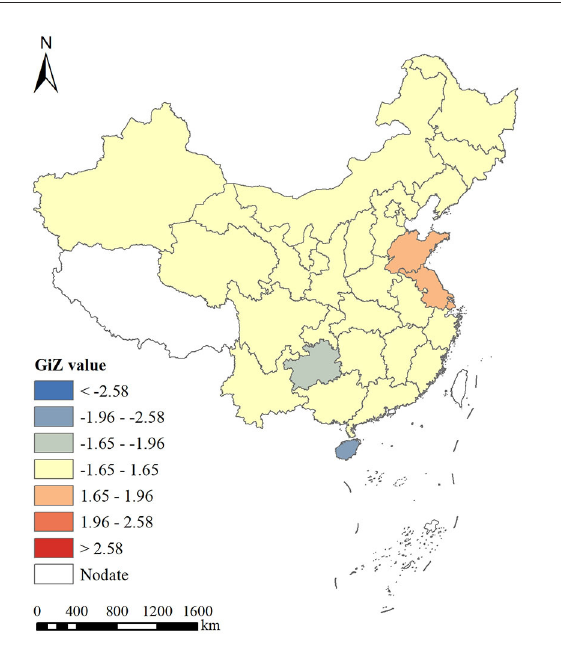
FIGURE2 Local spatial autocorrelation analysis for the prevalence of myopia in China from 1995 to 2014.